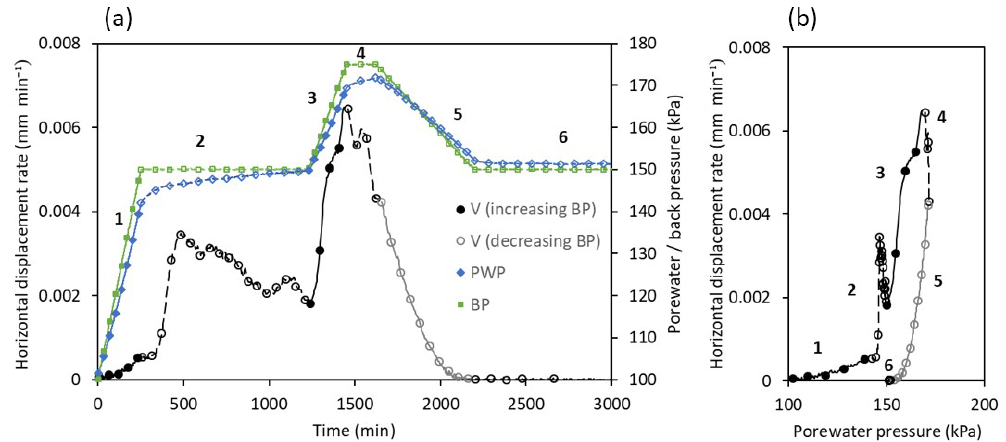
Figure 7. Relationship between shear surface displacement rate ( V ) and porewater pressure (PWP) during stepped pore pressure reinflation (BP) experiment conducted at mean effective stresses of 150kPa (UTC PP2) for periods of increasing back pressure (solid symbols), constant back pressure (hollow symbols) and decreasing back pressure. (a) Horizontal displacement rate against time in relation to the applied back pressure (BP) and measured porewater pressure (PWP) experiment UTC PP2. (b) Horizontal displacement rate against porewater pressure experiment UTC PP2.